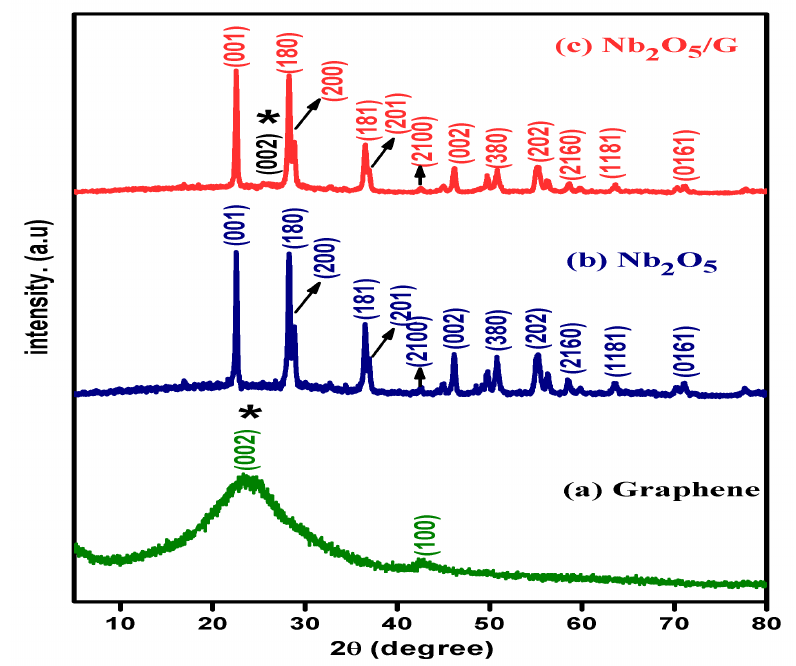
Figure 1. Powder X-ray diffraction patterns of ( a ) graphene, ( b ) Nb 2 O 5 , and ( c ) Nb 2 O 5 /G composite.